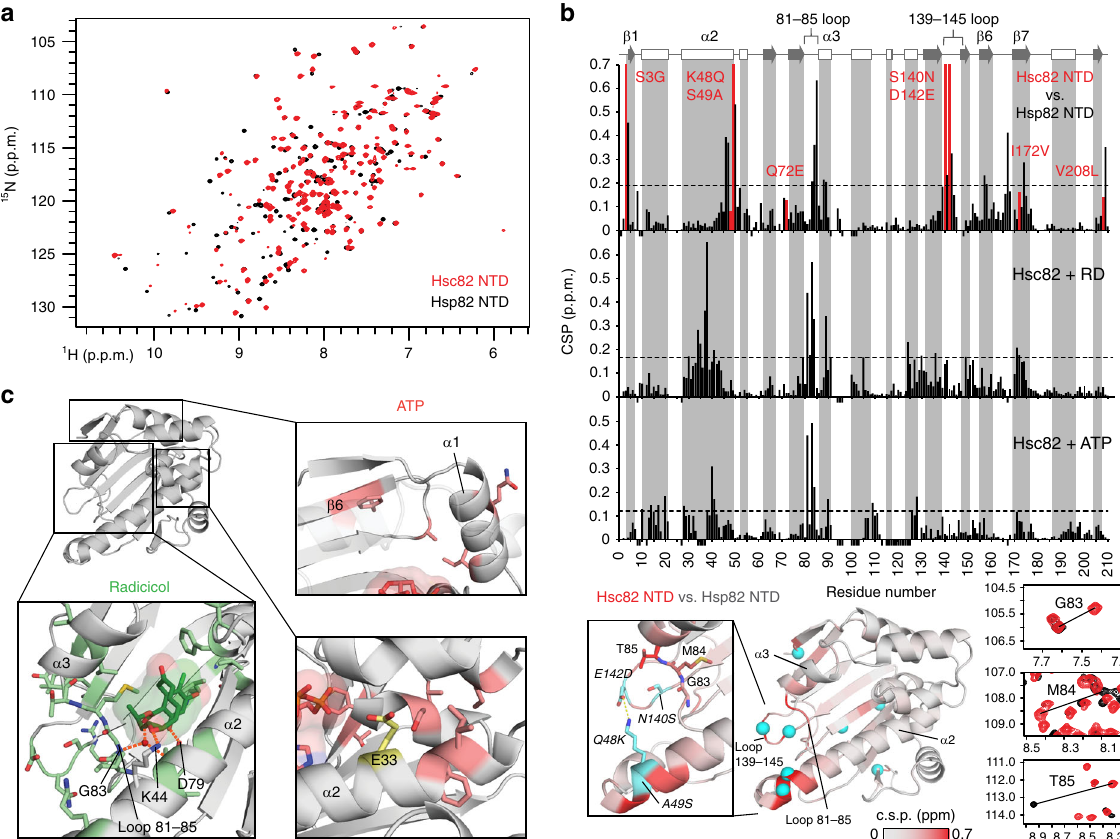
Fig. 5 Comparison of the NTDs of yeast Hsp90 isoforms by NMR. a Overlay of 1 H- 15 N HSQC spectra of Hsc82 (red) and Hsp82 (black). b Chemical shift perturbation (CSP) of apo-Hsc82 vs. apo-Hsp82 (top), Hsc82 + RD (middle), and Hsc82 + ATP (bottom). Red bars indicate residues that differ between the two isoforms, negative bars represent residues that are missing. Secondary structure elements derived from NMR secondary chemical shifts using TALOS + are shown on top (arrow: β -strand: rectangles: α -helix). The CSP comparing isoforms are mapped onto the crystal structure of Hsp82 NTD (PDB id 1AH6 27 , bottom), with isoform-speci fi c residues shown as cyan spheres. Inset shows a close-up view of the C-end of helix α 2 and surrounding loops (bold), together with the salt bridge between Lys48 and Asp142 (italic). Panels at the right are zoomed views of the spectra in a showing peak shifts from residues of the 81 – 85 loop. c Mapping of differential CSPs of the two isoforms upon binding of RD (green sticks) and ATP (red sticks). For RD, regions with higher deviations correspond to loop 81 – 85, helixes α 2, and α 3 (bold), while for ATP to strand β 6 and helix α 1, together with residues surrounding the catalytic residue Glu33